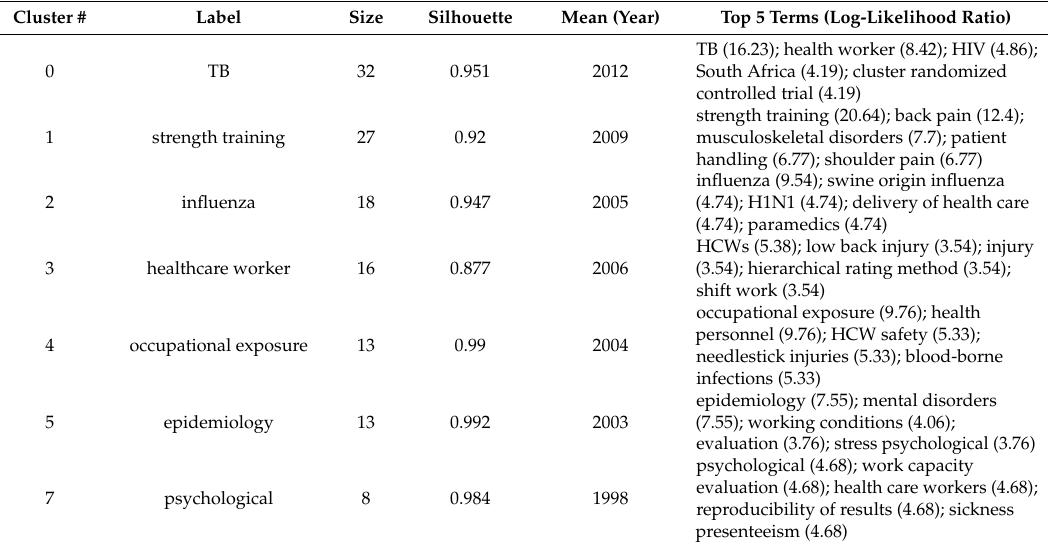
Table 4. Seven largest clusters sorted by